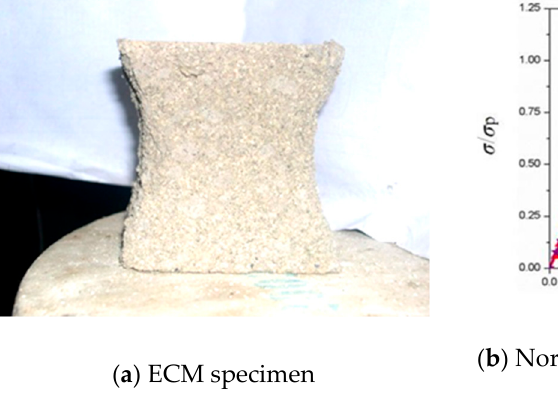
Figure 1. Experimental